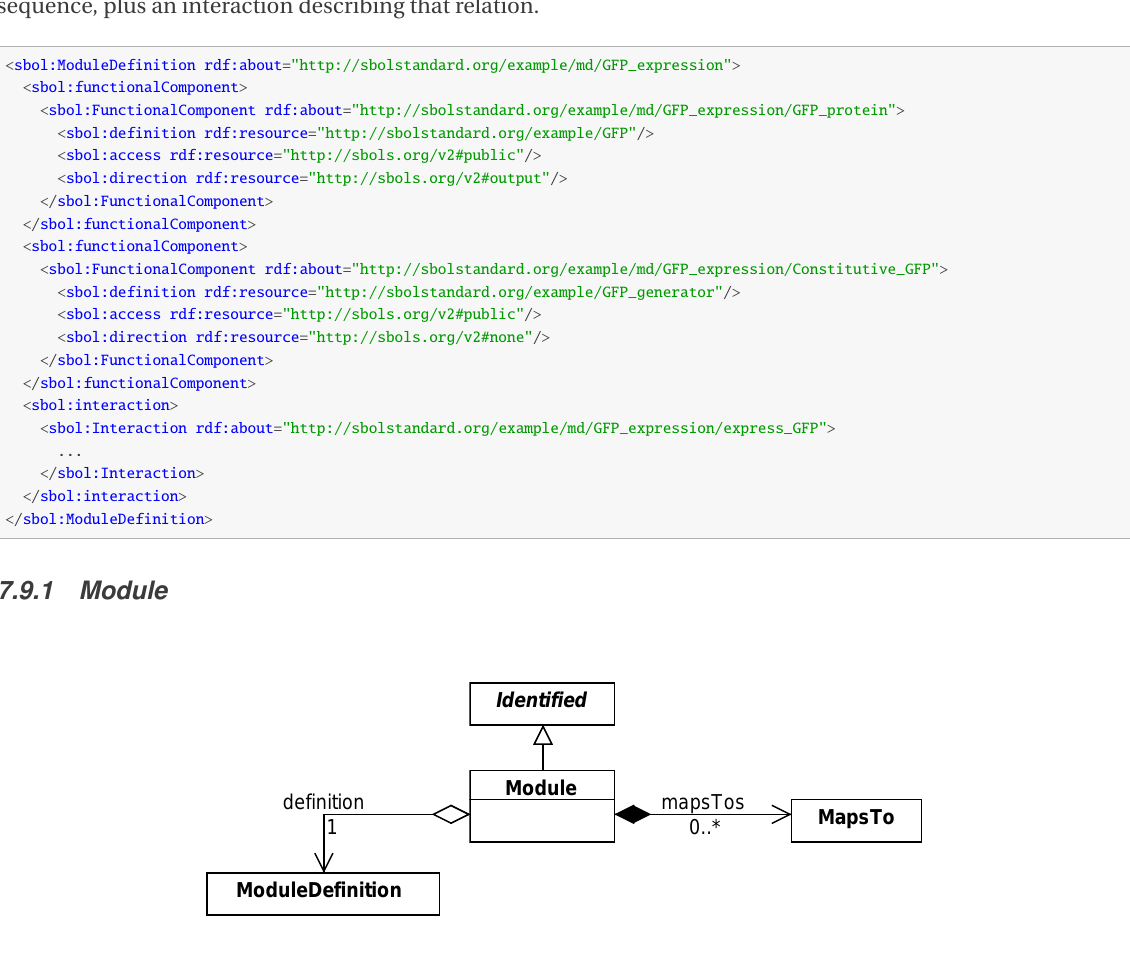
Figure 16: Diagram of the Module class and its associated